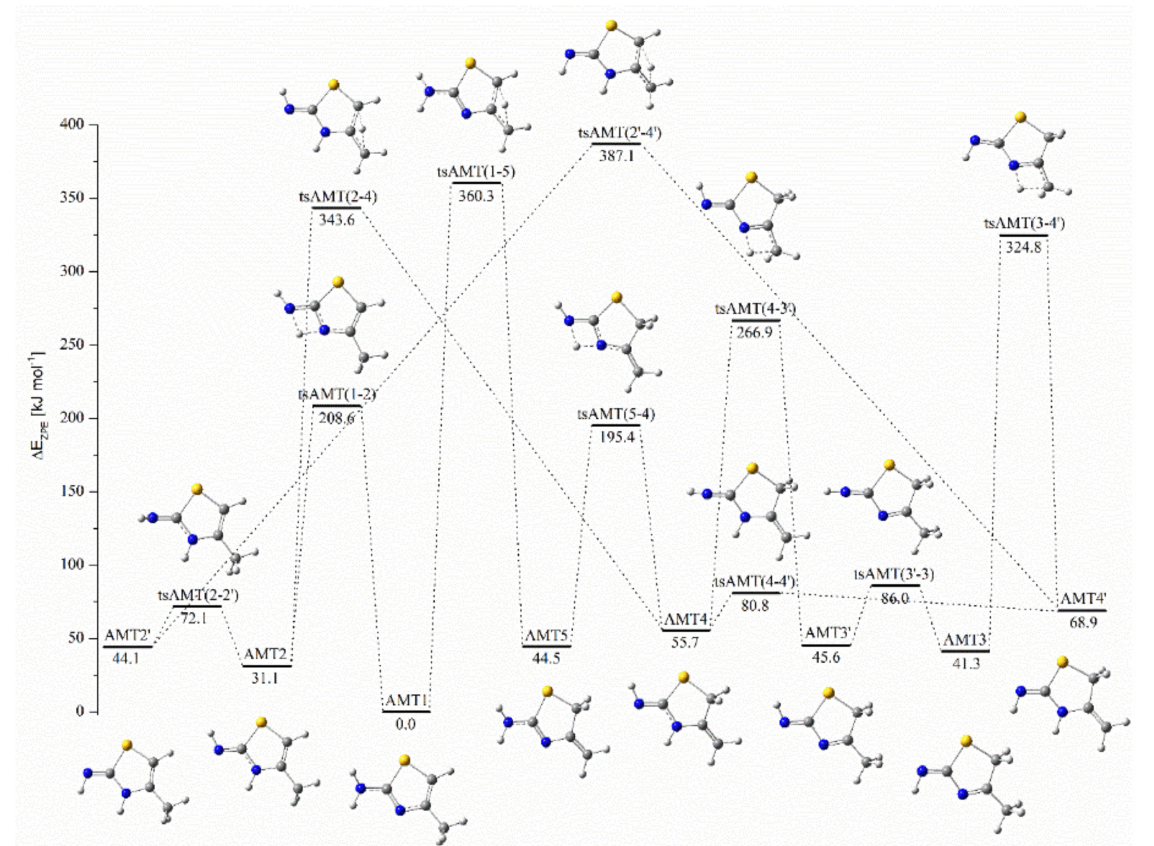
Figure 1. ZPE corrected potential energy diagram for AMT